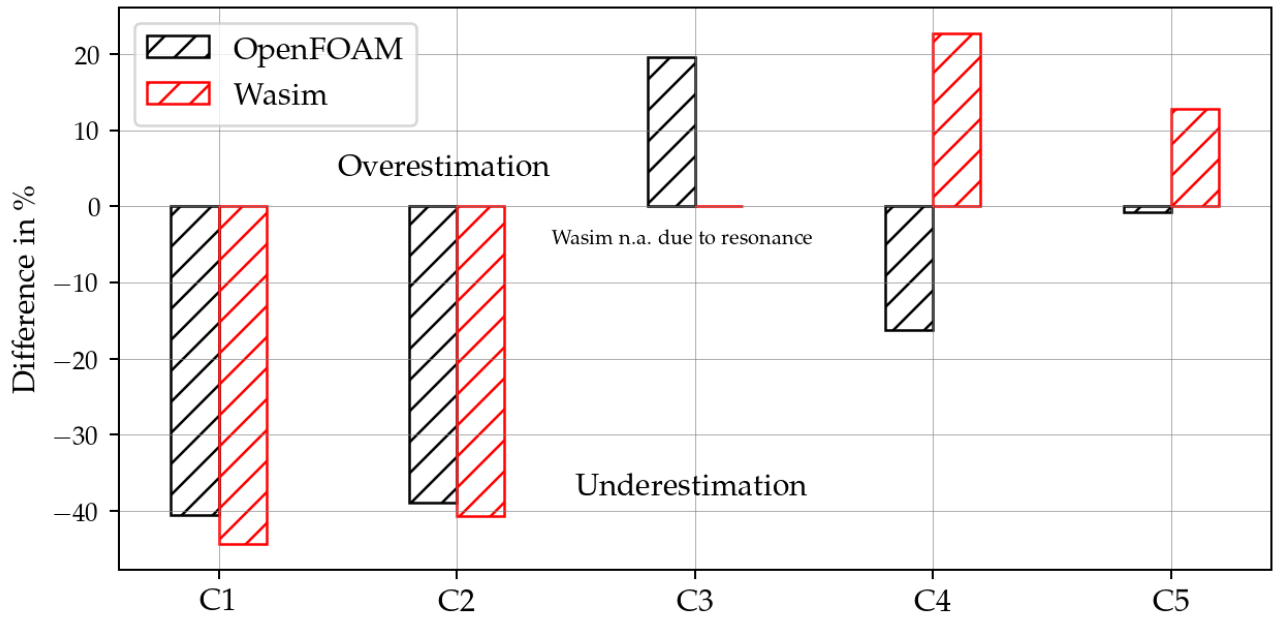
Figure 32. Difference of numerical and experimental total resistance coefficients for the KRISO con- tainership.